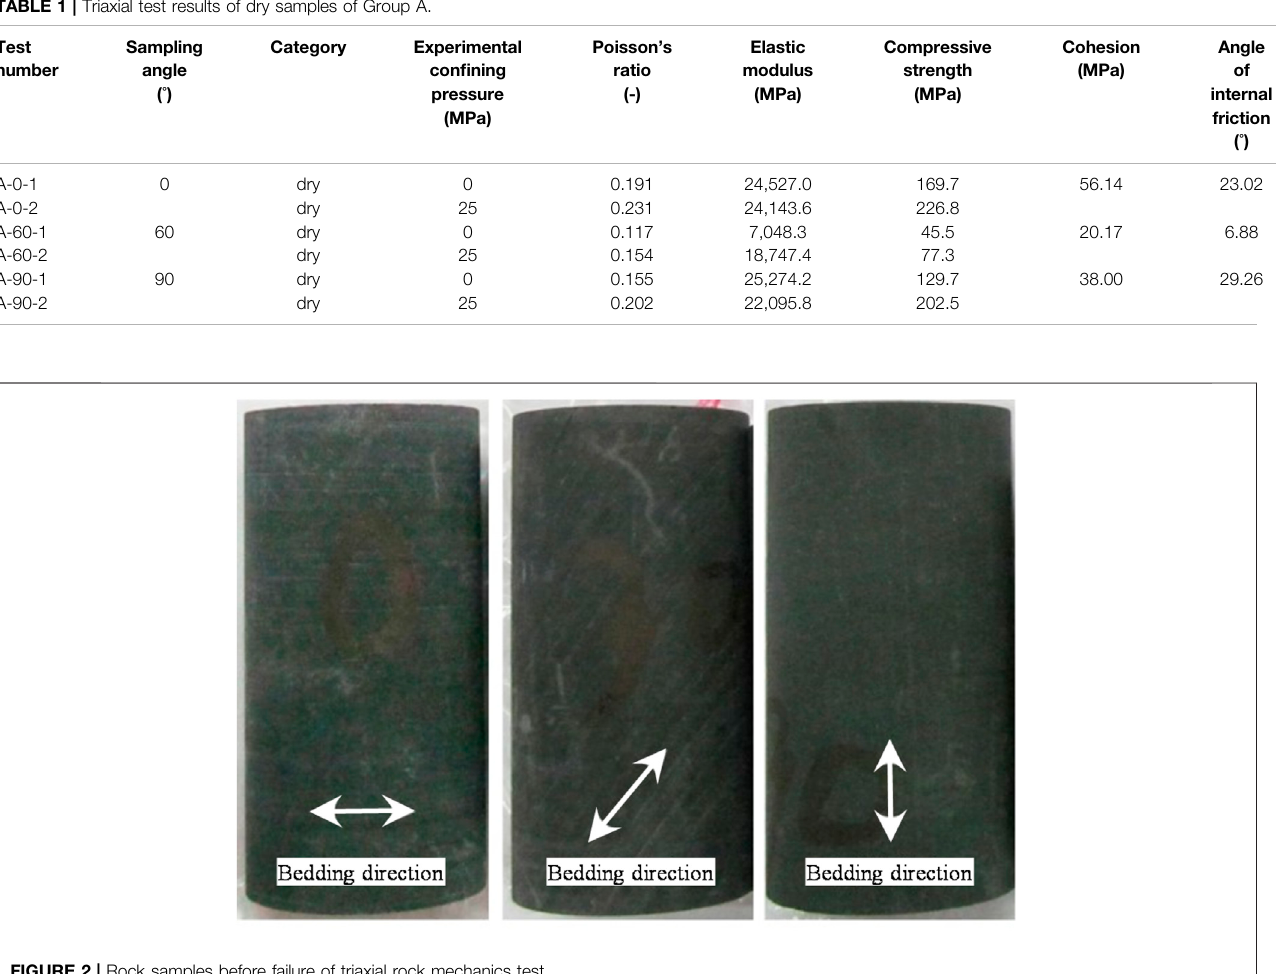
FIGURE 2 | Rock samples before failure of triaxial rock mechanics